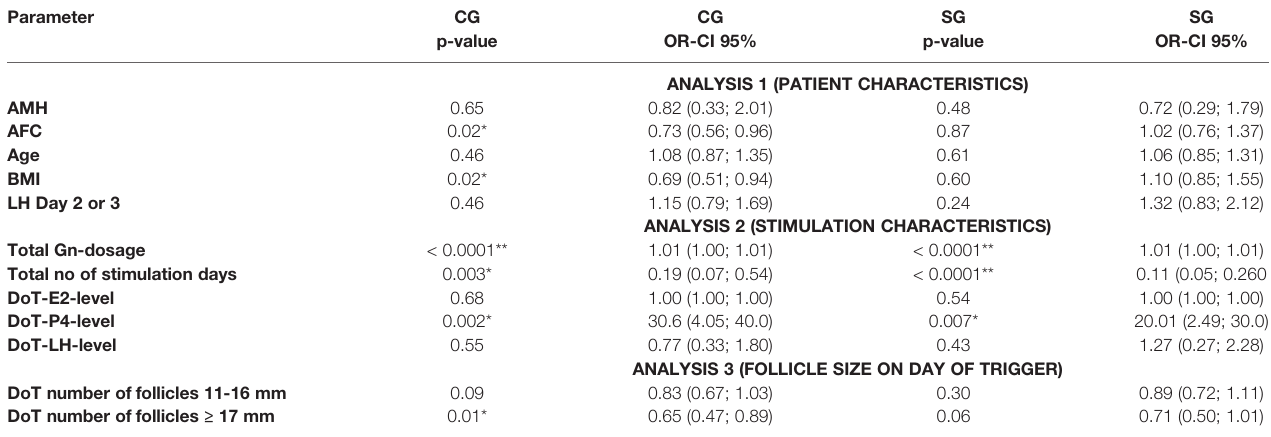
TABLE 5 | Multivariate analysis – correlation of DoT-FSH-levels with patient characteristics, stimulation characteristics and follicle size. Parameter